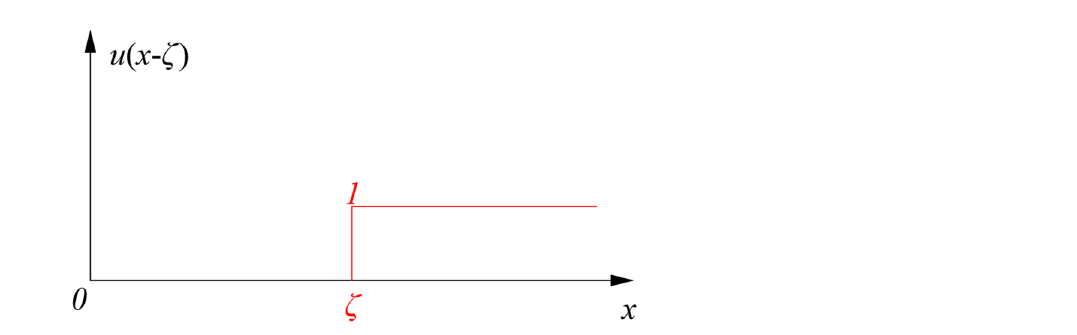
Figure 3. The unit step